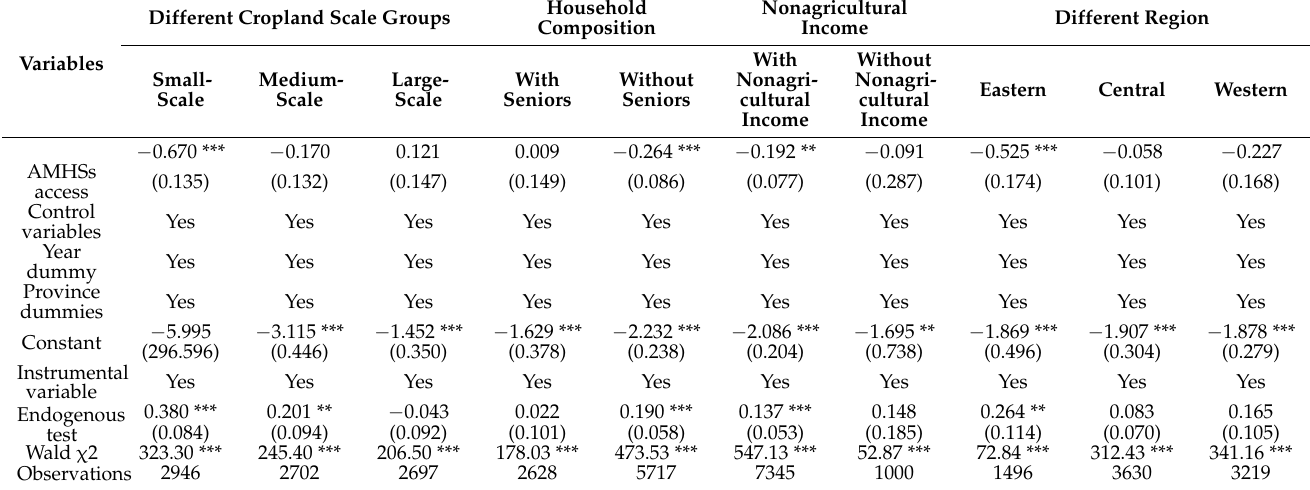
Table 4. Heterogeneity analysis